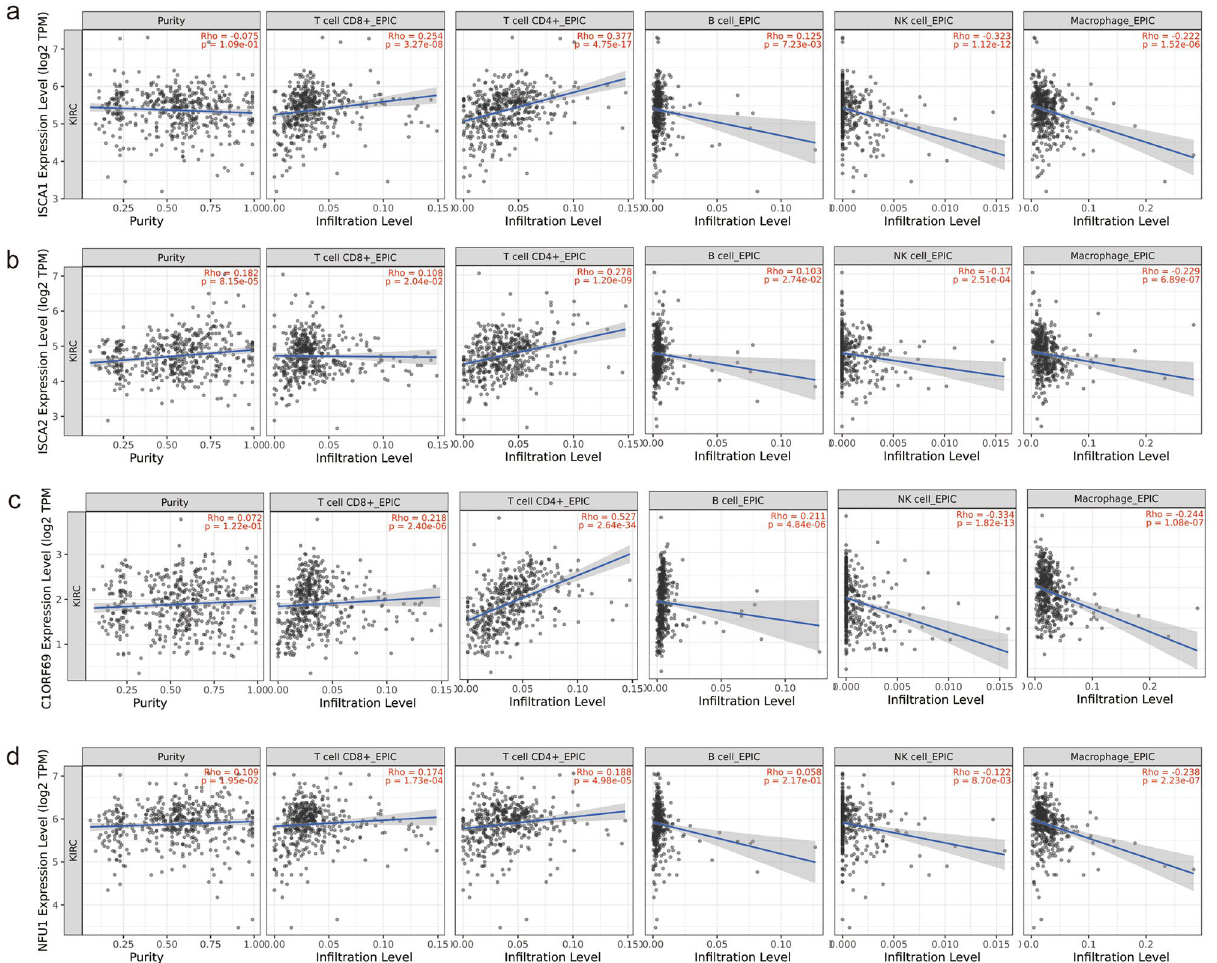
Figure 4. Correlation between the MMDS related iron–sulfur protein genes and tumor-infiltrating immune